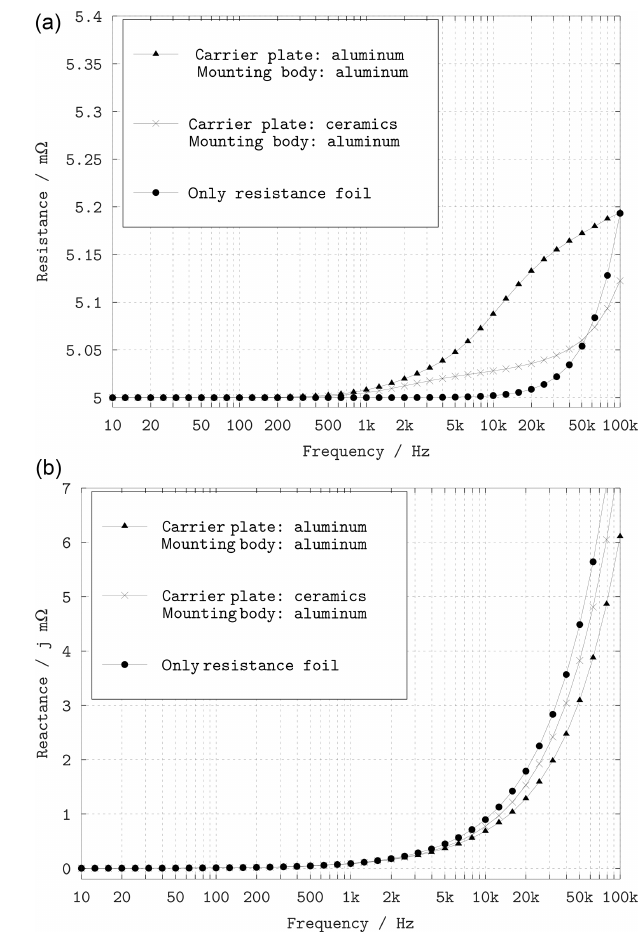
Figure 6. Simulation of the shunt resistance (the real part in a ) and the shunt reactance (the imaginary part in b ) with variation in the assembly of the shunt: carrier plate made of aluminum or ceramics and the resistive foil itself without carrier plate and mounting body.